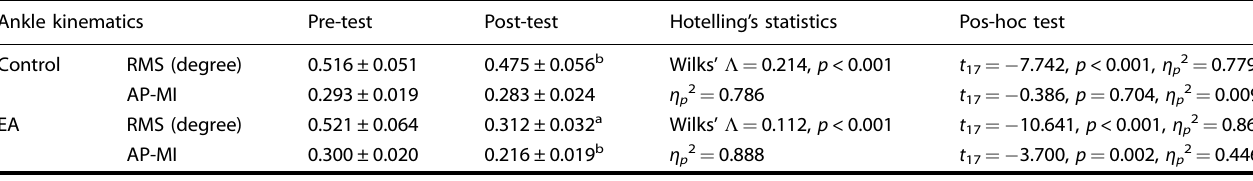
Fig. 2 The results of postural fl uctuation properties and ankle kinematics properties for the control and EA groups. The contrasts of standardized differences in postural fl uctuation properties (sample entropy (SampEn) and mean frequency (MF)(A), and in ankle kinematics properties (root mean square (RMS) and ankle – plate mutual information (AP-MI))(B) between the two groups. (EA: error ampli fi cation) (The error bars on the bar charts represent standard error.). Table 2. The comparison of ankle kinematics (root mean square (RMS) and ankle – plate mutual information (AP-MI)) between the pre-test and post- test for the error ampli fi cation (EA) and control